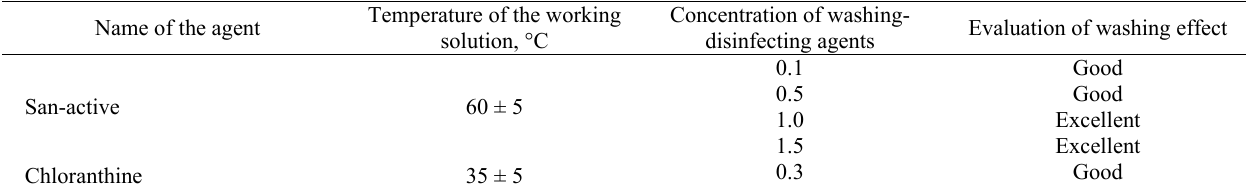
Washing capacity of the “San-active”, n = 12